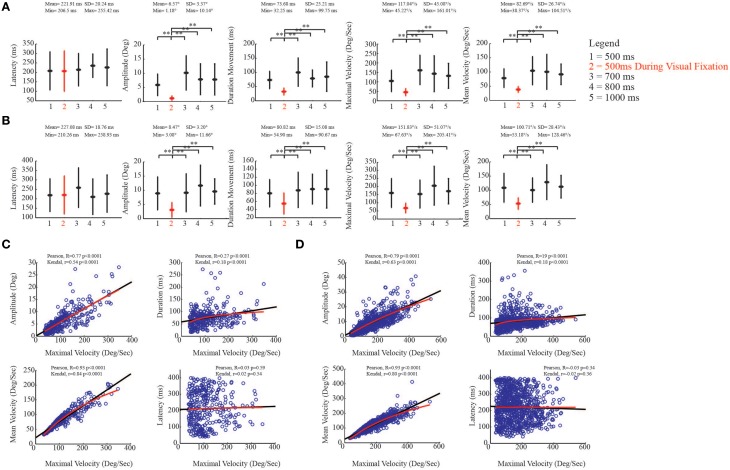
Kinematic study of the evoked eye movements. (A) Plots put in relation eye kinematic parameters of the core region with the duration of stimulation (numbers on x-axis), during visual fixation task (red), and spontaneous conditions (black). The descriptive statistic shows data which are means ± SEM of 353 determinations; **p < 0.05. Min corresponds to the average minimum value within the 5 conditions. Max corresponds to the average maximum value within the 5 conditions. (B) Plots put in relation eye kinematic parameters of the belt region with the duration of stimulation (numbers on x-axis), during visual fixation task (red), and spontaneous conditions (black). Latency, movement amplitude, movement duration, maximal and mean velocities are studied. Data are means ± SEM of 993 determinations; **p < 0.05. (C) Correlation analysis in the core region. Black line represents Pearson correlation, while red line represents non-linear regression (Kendall). Maximal velocity (x-axis) is compared with remaining kinematic parameters (y-axis). (D) Correlation analysis in the belt region.